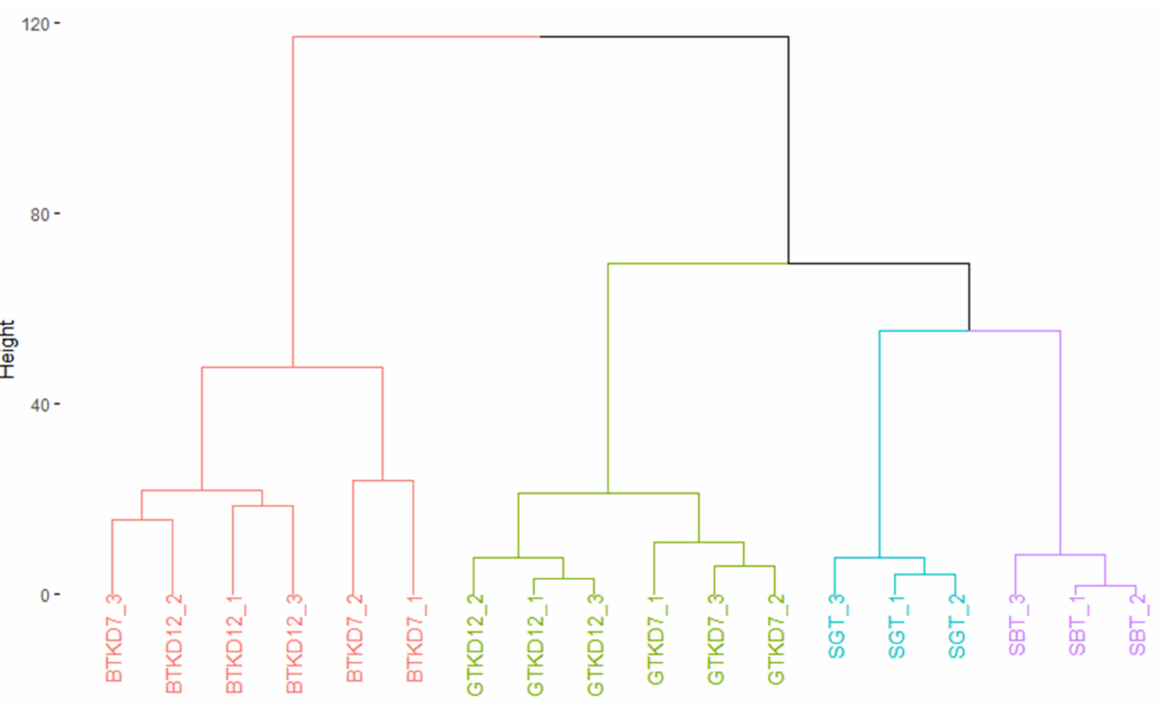
Figure 1. Dendrogram showing composition similarities between the three replicates of sugared black tea (SBT), sugared green tea (SGT) and corresponding kombucha samples (BTK and GTK) at day 7 (D7) and day 12 (D12), structured after Hierarchical Clustering Analysis. To achieve that, it is necessary first to define terms and the way data are represented. The approach is detailed in Figure